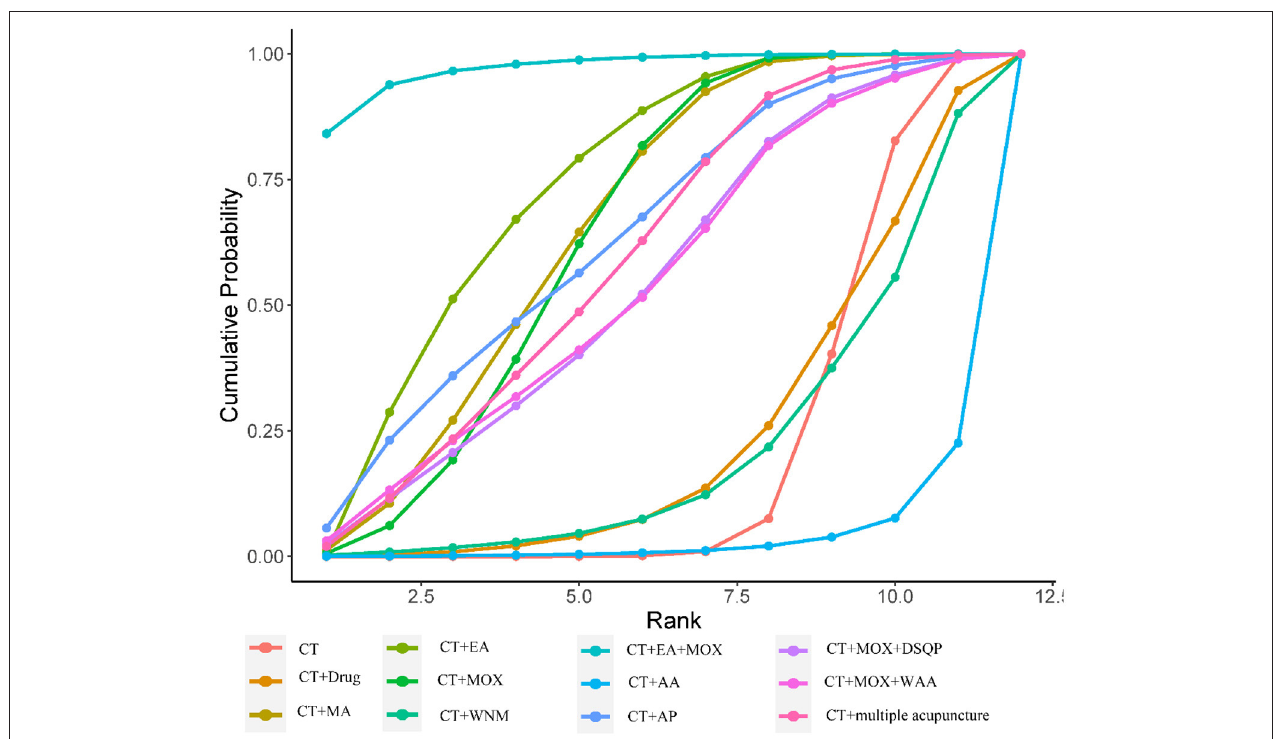
FIGURE 4 | Cumulative probability ranking curve of different interventions for CER. The vertical axis represents cumulative probabilities, while the horizontal axis represents ranks.